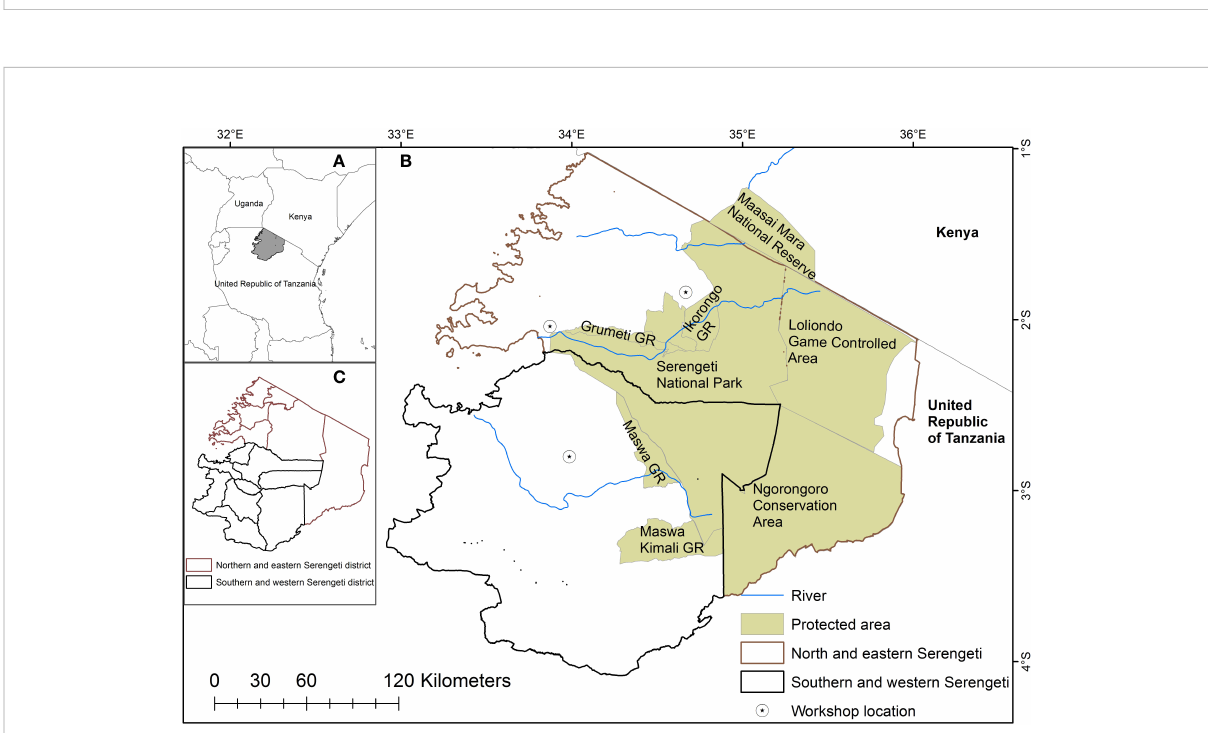
FIGURE 2 The study covered the wider Serengeti ecosystem located in northwestern Tanzania (A) . The study area was divided into 1) northern and eastern Serengeti (shown by brown boundaries) and 2) southern and western Serengeti (shown by black boundaries) in images (B) and (C) . The Serengeti National Park cuts across the two study areas. GR represents Game Reserve.